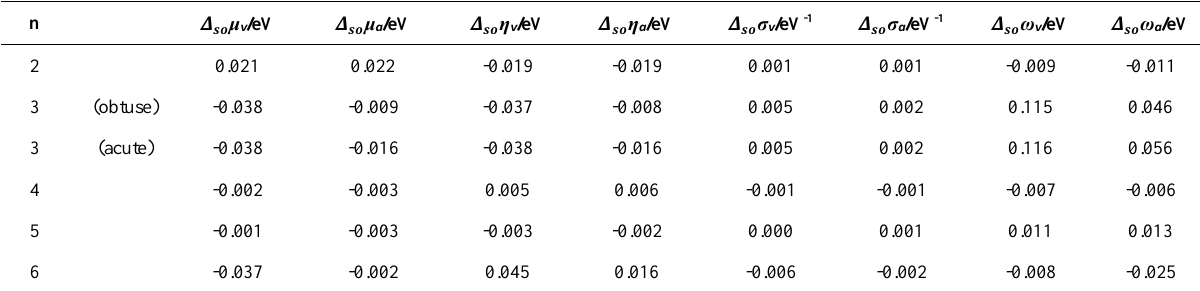
Table 6. Spin-orbit coupling (SOC) corrections to the vertical and adiabatic chemical potential ( 𝜟 𝒔𝒐 μ /eV), hardness ( 𝜟 𝒔𝒐 η /eV), softness ( 𝜟 𝒔𝒐 σ /eV -1 ) and electrophilicity index ( 𝜟 𝒔𝒐 ω /eV)